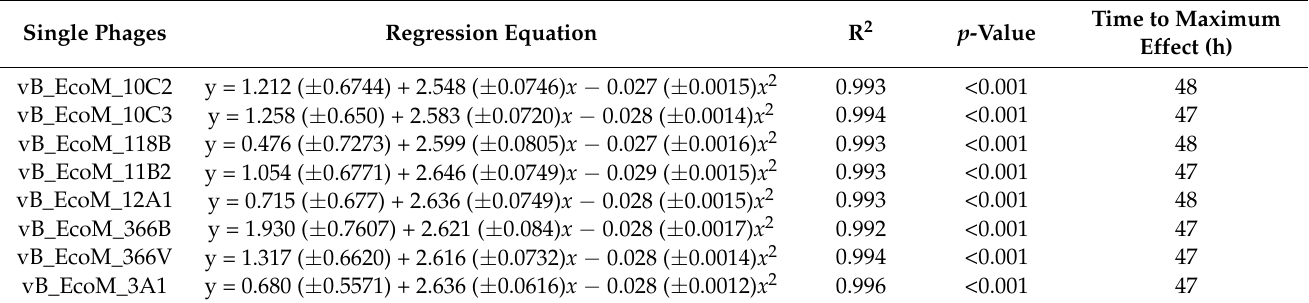
Table 5. Relationship between in vitro ruminal incubation time ( x ) and percent reduction in E. coli O177 cells ( y ) when challenged with single phages.